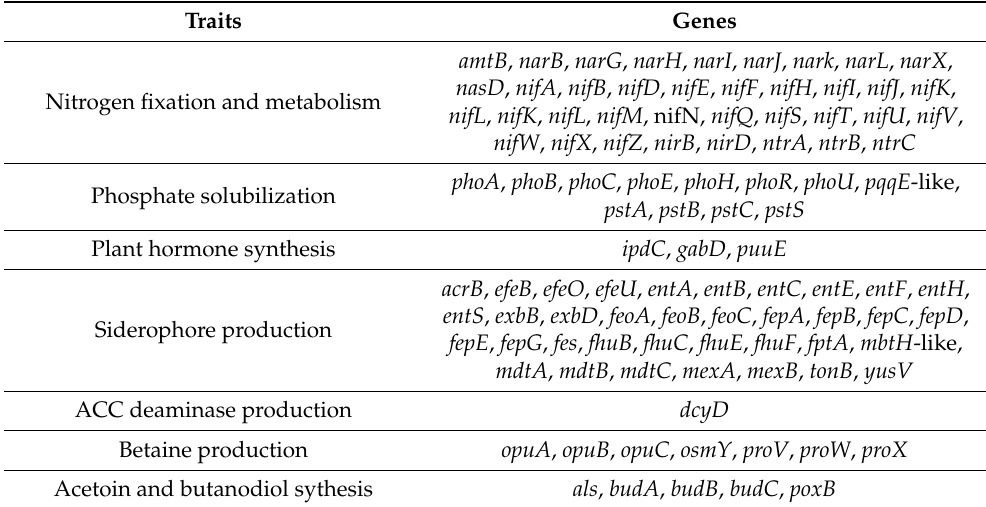
Table 3. Genes of FY-07 involved in plant